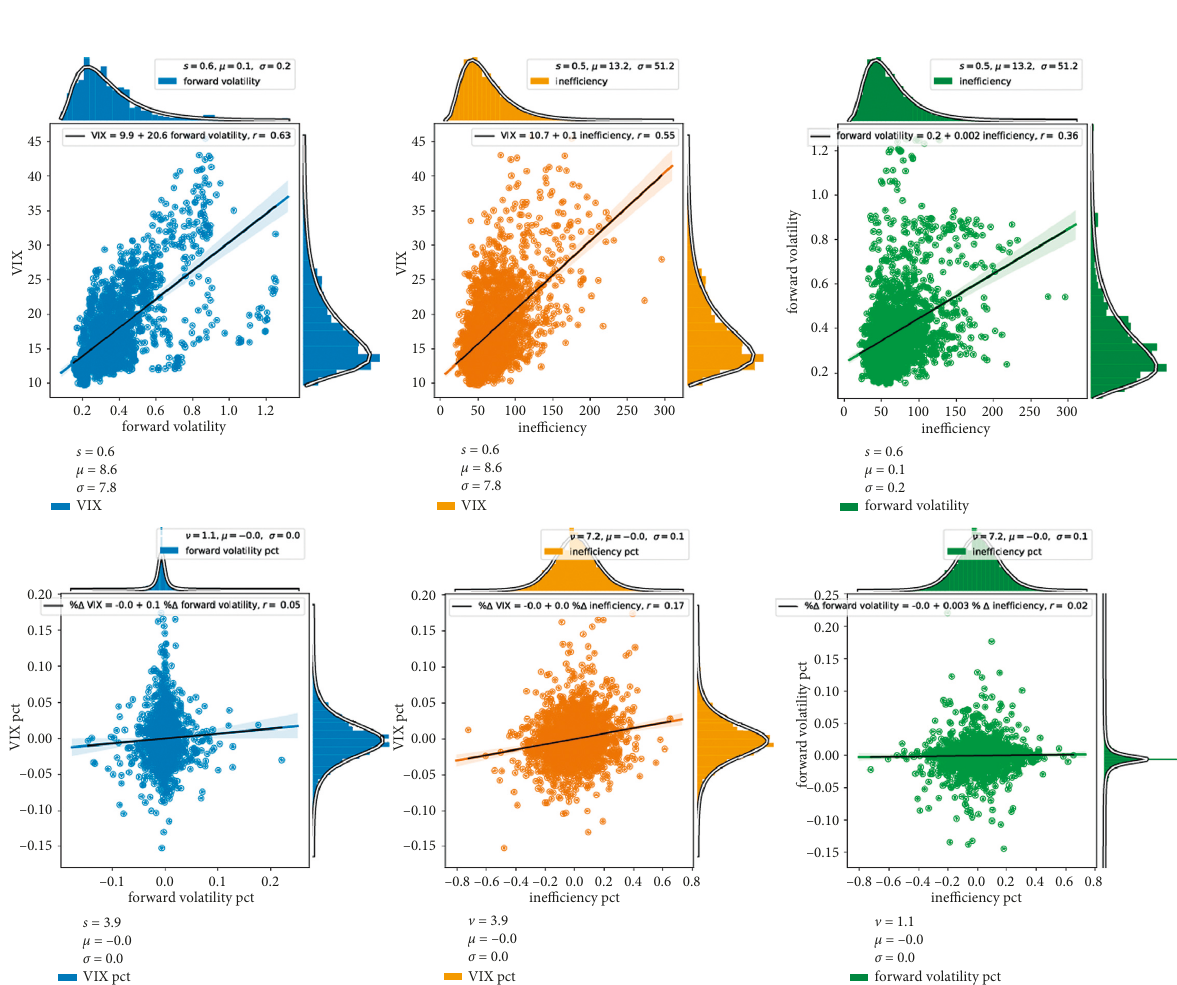
Figure 8: Common statistical measures of security price volatility, such as the VIX or rolling standard deviation of returns, are correlated with I